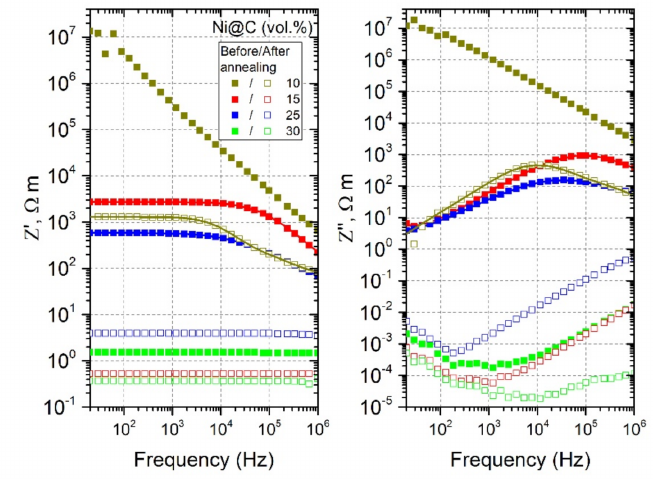
Figure 8. Frequency dependence of the complex impedance (calculated according to Equations (5) and (6)) for mono-filled Ni@C/epoxy composites at room temperature before and after annealing at 500